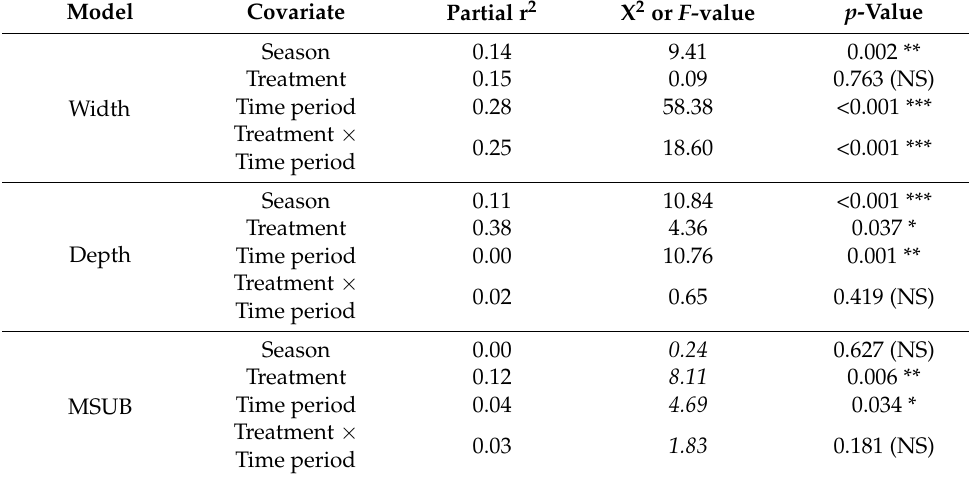
Table 1. Hydromorphological responses to river restoration indicated by linear model or linear mixed-effect model outputs; the significance tests for these, respectively, use X 2 and F-values (the latter have been italicised). Stars denote the degree of significance: * p ≤ 0.05; ** p ≤ 0.01; *** p ≤ 0.001; NS,